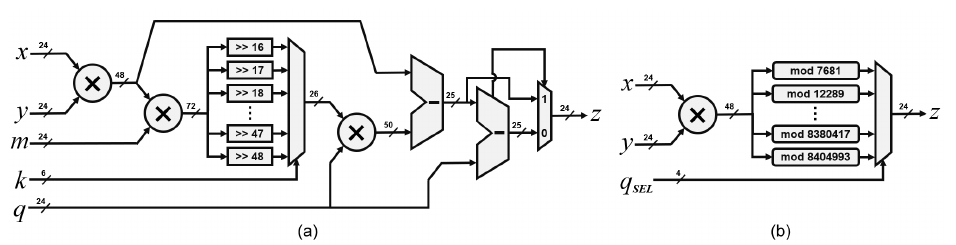
Figure 2: Two different single-cycle modular multiplier architectures with (a) fully config- urable and (b) pseudo-configurable modulus for Barrett